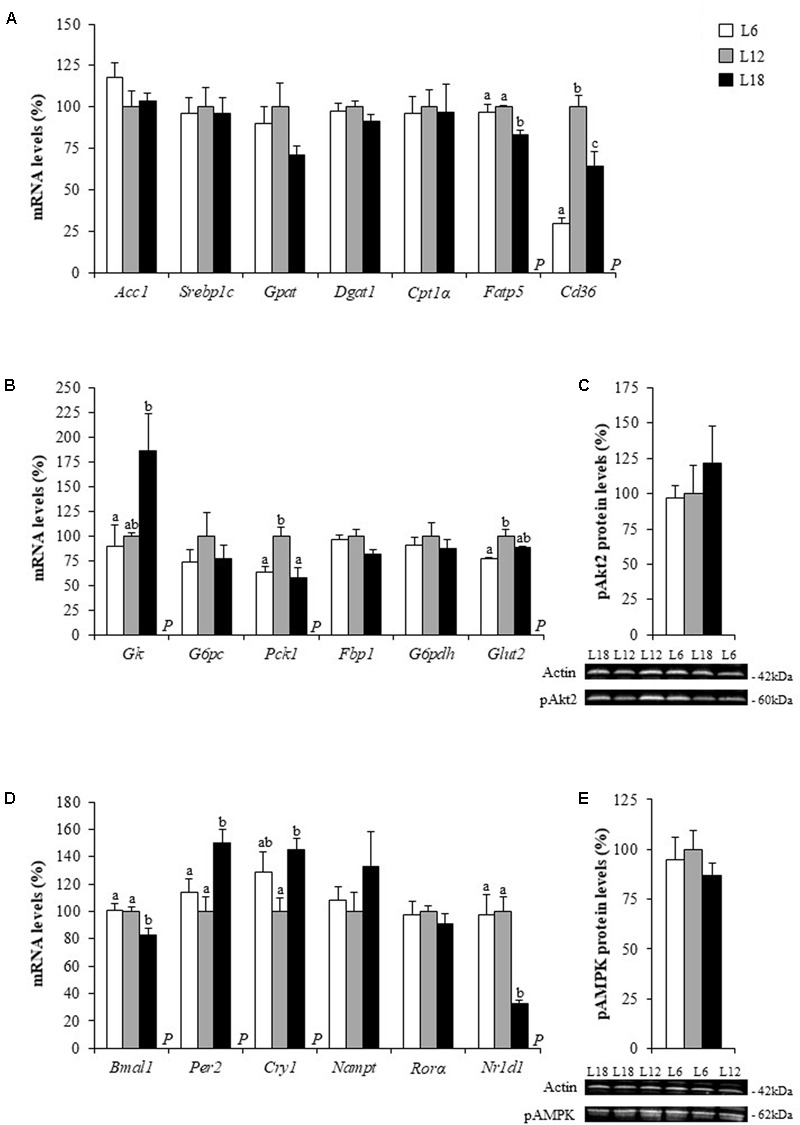
The mRNA levels of lipid metabolism (A), glucose metabolism (B) and circadian rhythm-related genes (D) and the protein levels of pAkt2 (C) and pAMPK (E) in the liver of male Fischer 344 rats fed with a standard diet and exposed to three different photoperiods for 14 weeks. Data are represented as the mean ± SEM (n = 6). P, photoperiod effect (p < 0.05, one-way ANOVA). abMean values with different letters are significantly different among groups (p < 0.05, Duncan post hoc test). Acc1, acetyl CoA carboxylase 1; β-actin, actin beta; Bmal1, brain and muscle Arnt-like protein-1; Cd36, fatty acid translocase, homolog of CD36; Cpt1α, carnitine palmitoyltransferase 1 alpha; Cry1, cryptochrome circadian clock 1; Dgat1, diacylglycerol acyltransferase 1; Fatp5, fatty acid transport protein 5; Fbp1, fructose-1,6-biphosphatase 1; G6pc, glucose-6-phosphatase, catalytic subunit; G6pdh, glucose-6-phosphate dehydrogenase; Glut2, glucose transporter 2; Gk, glucokinase; Gpat, glycerol-3-phosphate acyltransferase; Hprt, hypoxanthine guanine phosphoribosyl transferase; Nampt, nicotinamide phosphoribosyltransferase; Nr1d1, nuclear receptor subfamily 1, group D, member 1; Per2, period circadian clock 2; Pck1, phosphoenolpyruvate carboxykinase 1; Ppia, peptidylprolyl isomerase A; Rorα, RAR-related orphan receptor A; Srebp1c, sterol regulatory element-binding protein 1c.